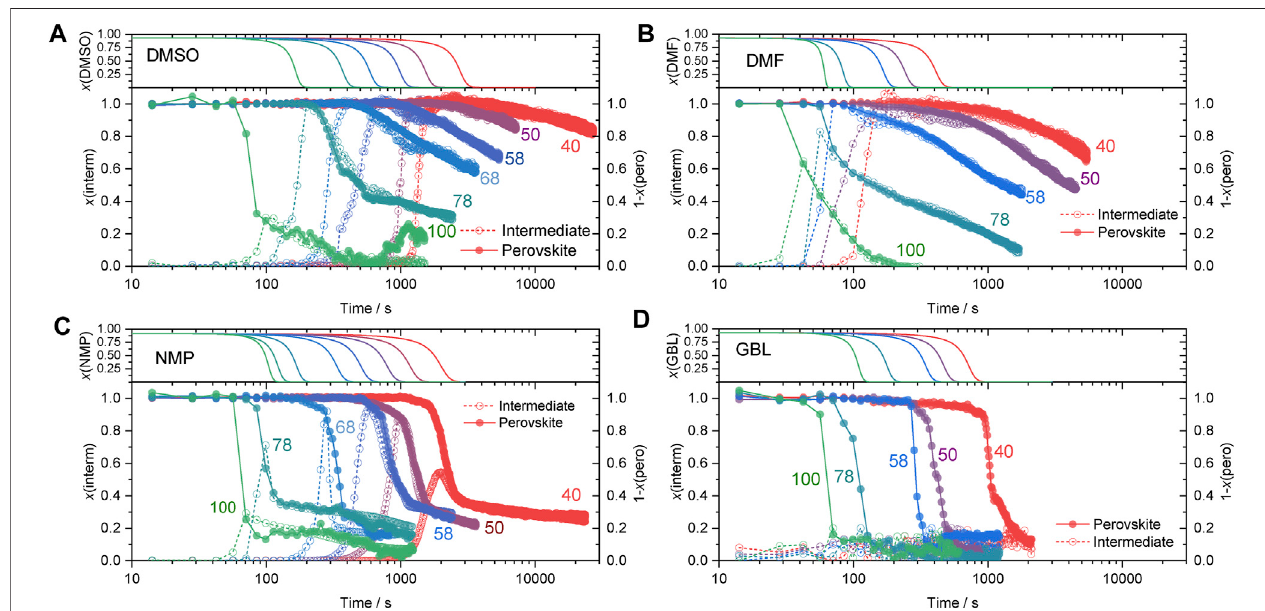
FIGURE 2 | Top) Simulated evolution of the fraction of solvent over time at different temperatures. Bottom) Fraction of intermediate phase peak, x (interm), (open symbol) and fraction of perovskite phase to be formed, 1- x (pero), (solid symbol) were obtained from integration of x-ray diffraction patterns during crystallization at different temperatures noted on the